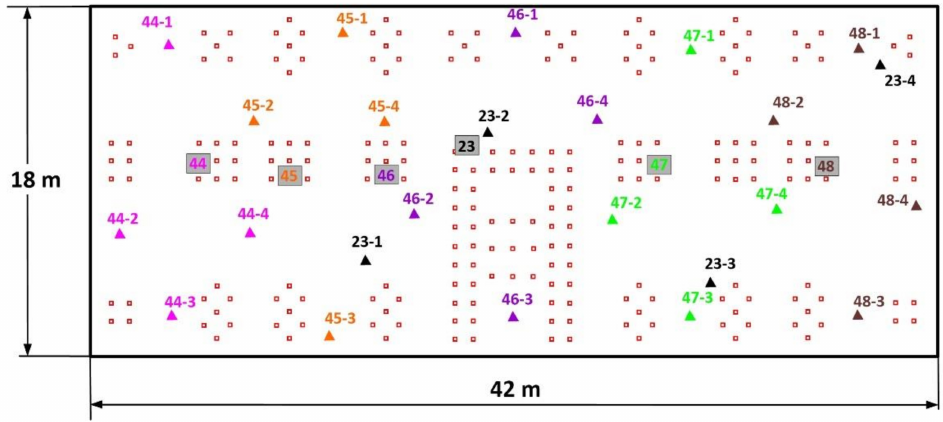
Figure 1. Scheme of the location of thermometric equipment of the SAMs and the PF under Building I. The triangles are the SAM wells, the squares are the SAM stations, and the dots are the